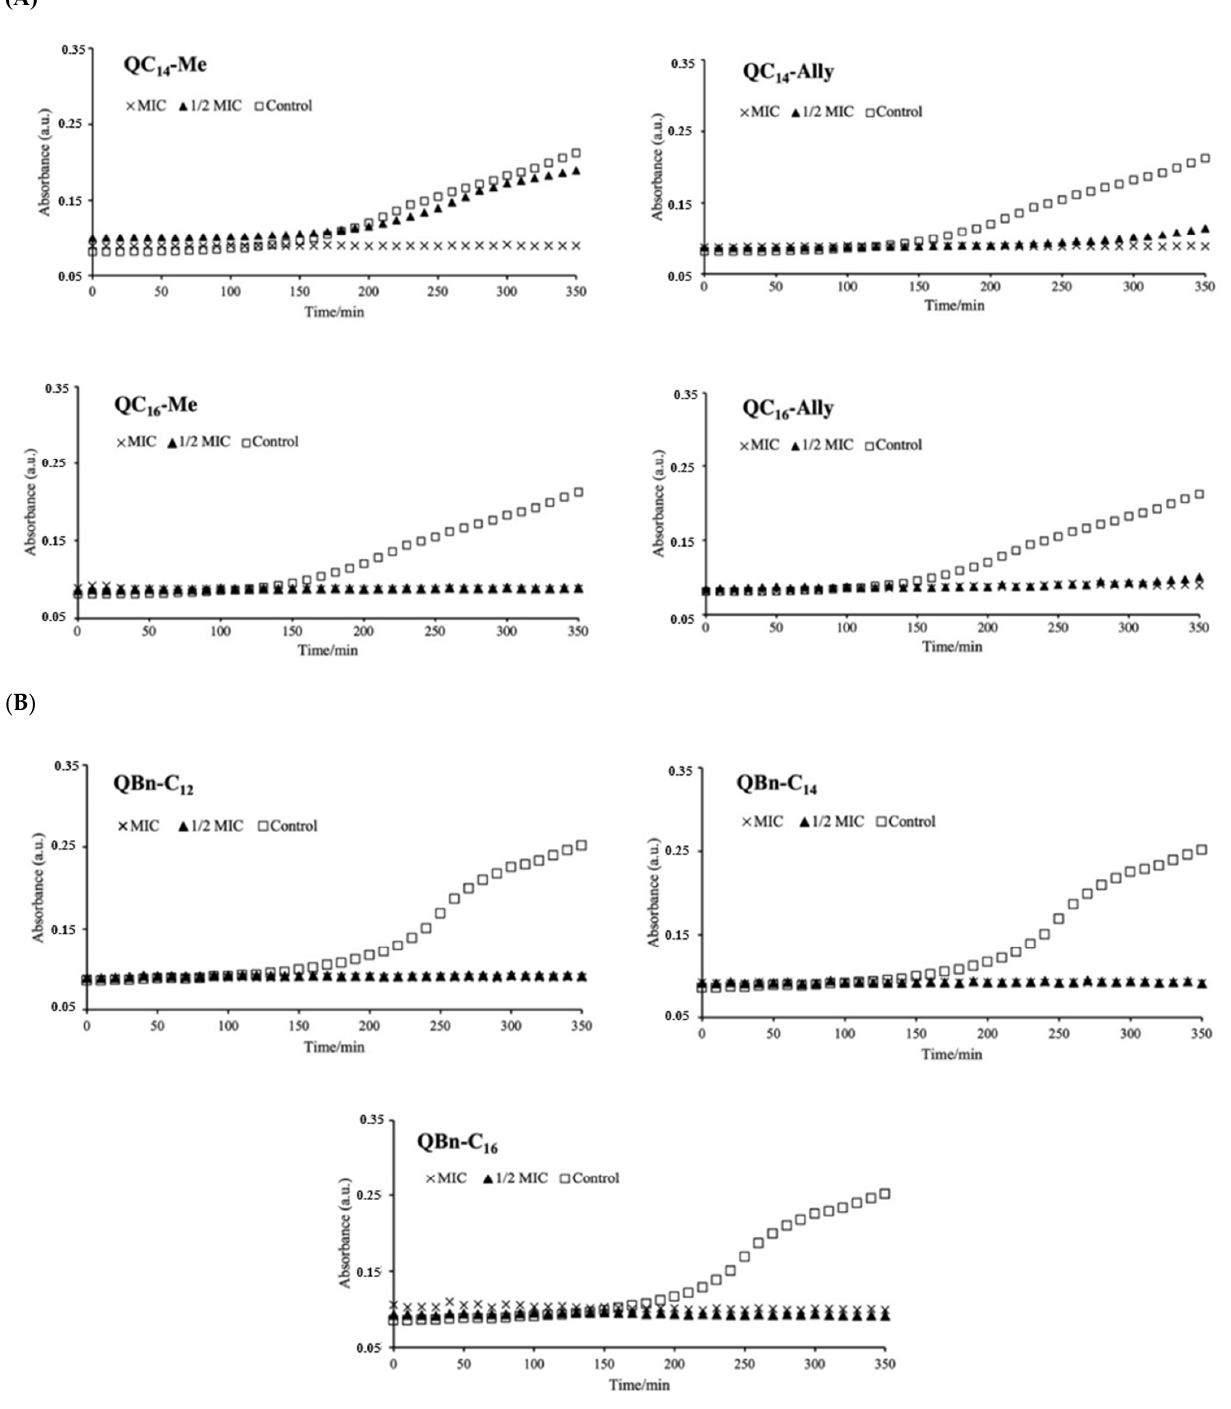
Figure 1. Time ‐ resolved growth analysis of Staphylococcus aureus ATCC 25923 during ~6 h incuba ‐ Figure 1. Time-resolved growth analysis of Staphylococcus aureus ATCC 25923 during ~6 h incubation tion with no antibacterial agent (control) and at MIC and ½ MIC of series 1 QC 14 ‐ Me , QC 14 ‐ Ally , with no antibacterial agent (control) and at MIC and 1 / 2 MIC of series 1 QC 14 -Me , QC 14 -Ally , QC 16 - QC 16 ‐ Me , and QC 16 ‐ Ally ( A ) and series 3 QBn ‐ C 12 , QBn ‐ C 14 , and QBn ‐ C 16 ( B ). Me , and QC 16 -Ally ( A ) and series 3 QBn-C 12 , QBn-C 14 , and QBn-C 16 ( B